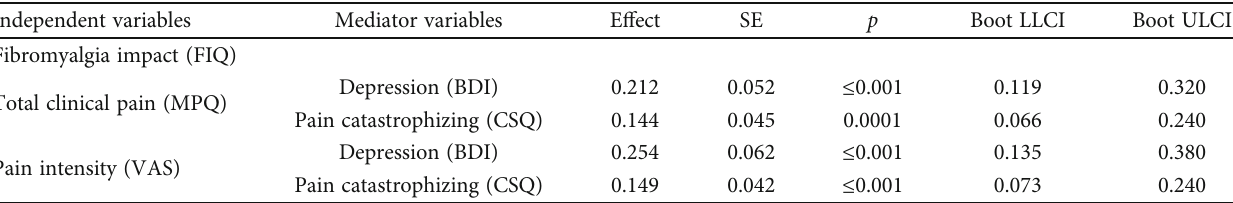
Table 3: Results of mediation analysis of the predictors of FIQ score. Independent variables